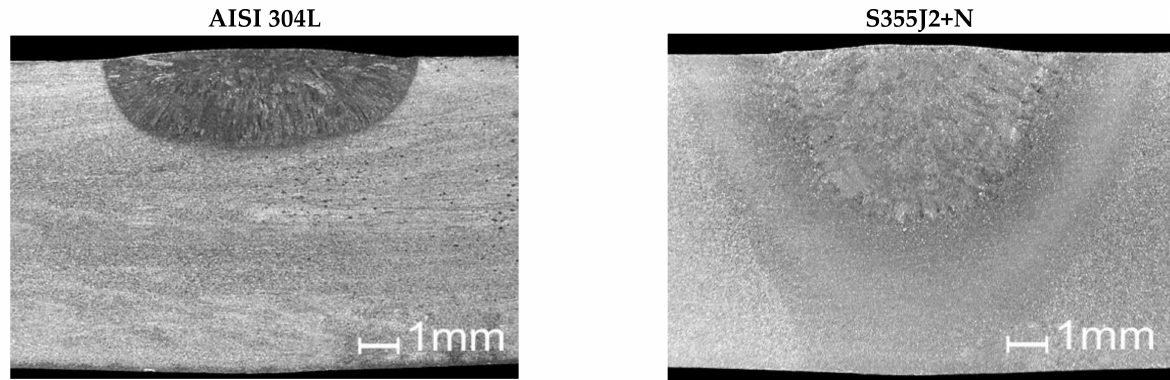
Figure 11. Macrostructure of the welds made on steel AISI 304L using NaF and Fe 2 O 3.